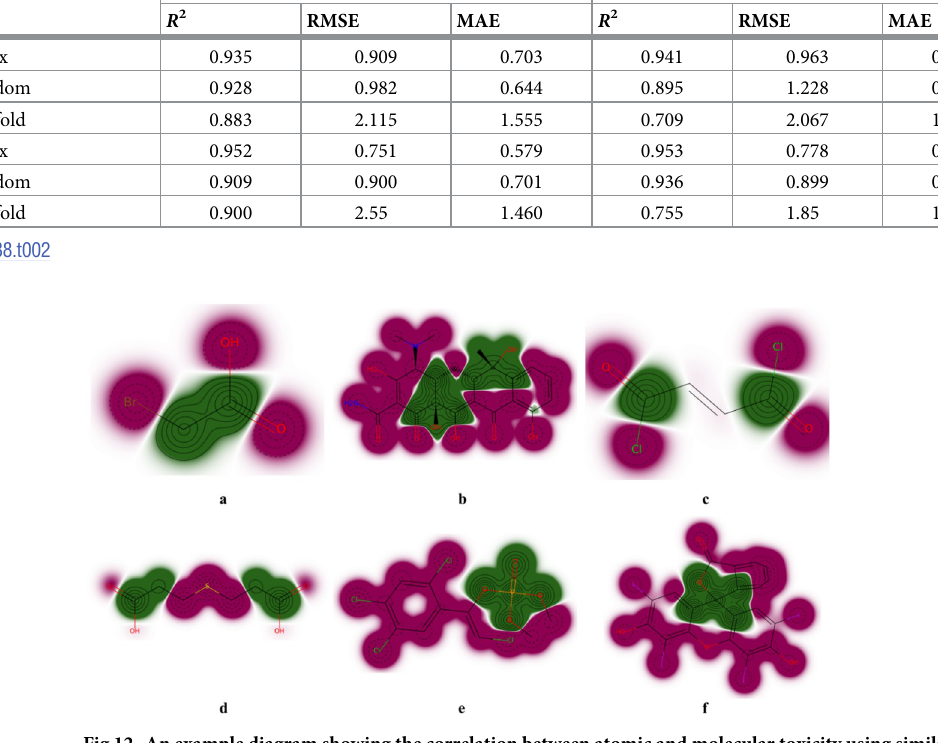
Table 2. The Performances in FreeSolv data set. R 2 , RMSE and MAE (kcal/mol) are provided to reflect the performance of the models. Model